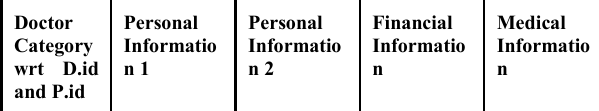
Table 4. Sample sensitivity calculation for medical data